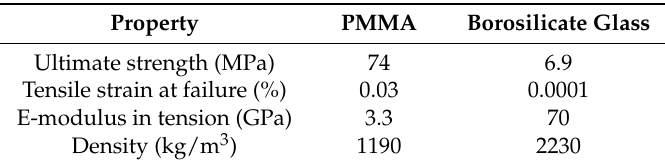
Table 5. Material properties of PMMA and Borosilicate glass.